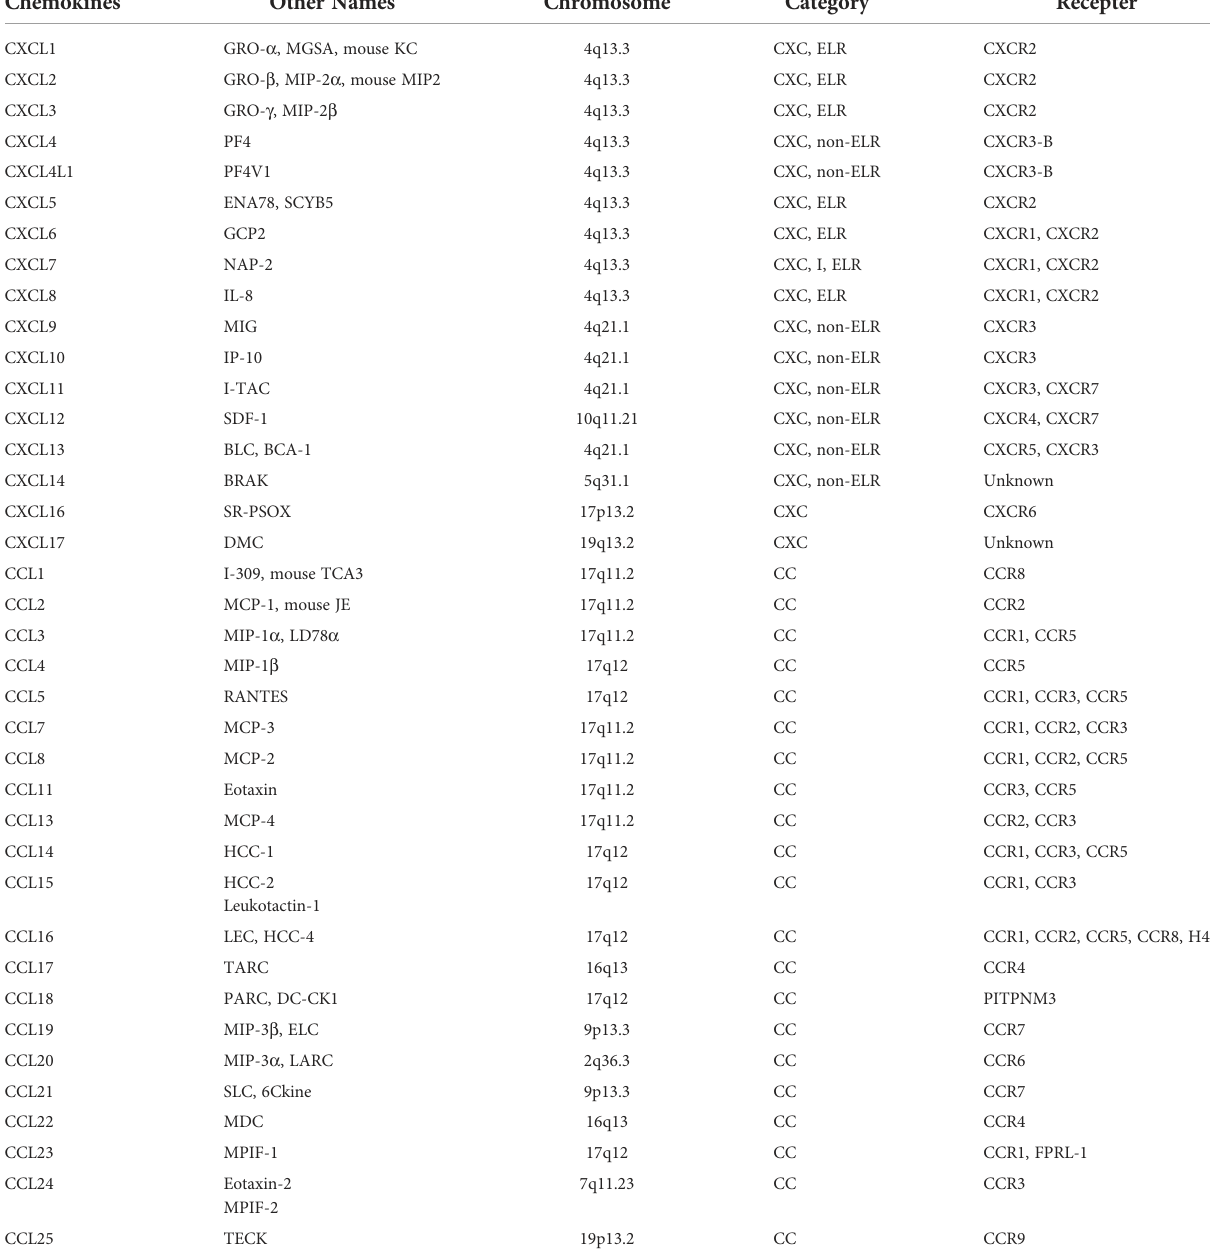
TABLE 1 chemokine receptors and their ligands.